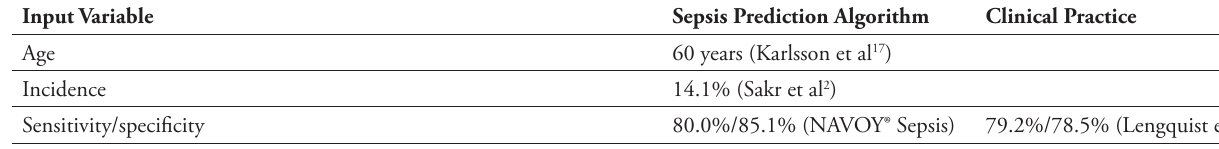
Table 1. Model Base Case